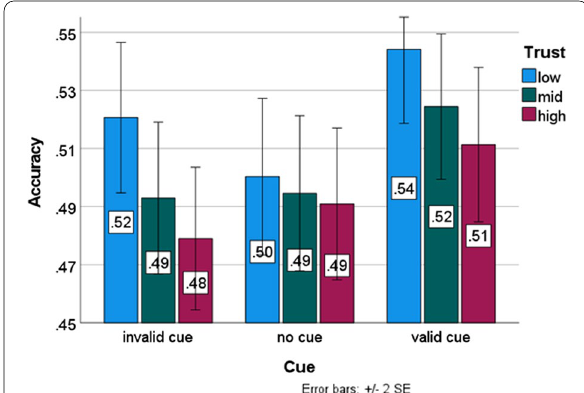
Fig. 4 Average accuracy per level of trust (low, mid, high) and cueing condition. Both a low trust in the authenticity (i.e. a high expectancy on the number of counterfeits) and valid cueing led to better performance. Error bars depict 95% confidence